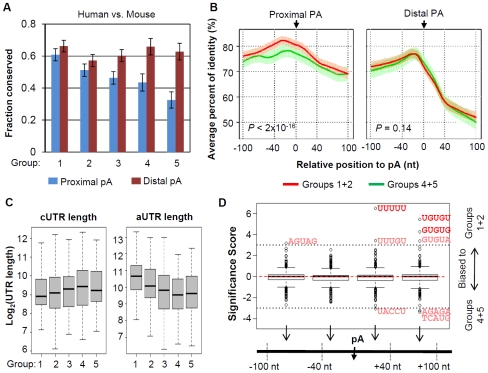
Analysis of poly(A) sites responsible for 3′UTR regulation.(A) Conservation of proximal and distal poly(A) sites between human and mouse genomes for different groups of genes. Gene groups are based on Figure 3B. P-value (Chi-squared test with null hypothesis being no difference between groups) = 4.1×10−4 for proximal poly(A) sites, and = 0.45 for distal sites. (B) Conservation of sequence surrounding proximal (left) and distal (right) poly(A) sites for groups 1+2 (red line) and groups 4+5 (green line). Y-axis is average percent of identity for a given nucleotide position, which was calculated using genome alignments of human, mouse, rat, and dog. X-axis is relative position to poly(A) site, with the cleavage site set at position 0. Standard errors are indicated by vertical bars along the lines. P-values are based on Wilcoxon matched-pairs test comparing 2 conservation profiles from −100 nt to +100 nt. Curves were smoothed by the Lowess regression method. (C) Distribution of cUTR length (left) and aUTR length (right) for genes in the 5 groups. P-value (Wilcoxon rank sum test) = 0.096 for cUTR length difference between groups 1+2 and groups 4+5, and = 2.7×10−9 for aUTR length difference. (D) Comparison of frequency of occurrence for all 5-mers in different regions surrounding proximal poly(A) sites for genes in groups 1+2 vs. those in groups 4+5. As indicated in the graph, 4 regions were examined, i.e. −100 to −41 nt, −40 to −1 nt, +1 to +40 nt, and +41 to +100 nt. The poly(A) site was set at position 0. Y-axis is the significance score (see Methods for detail). Pentamers with significance score >3 or <−3 are shown in red. Significant ones after P-value correction by the Benjamin-Hochberg method are shown in dark red, i.e. UUUUU, UGUGU, and GUGUG.